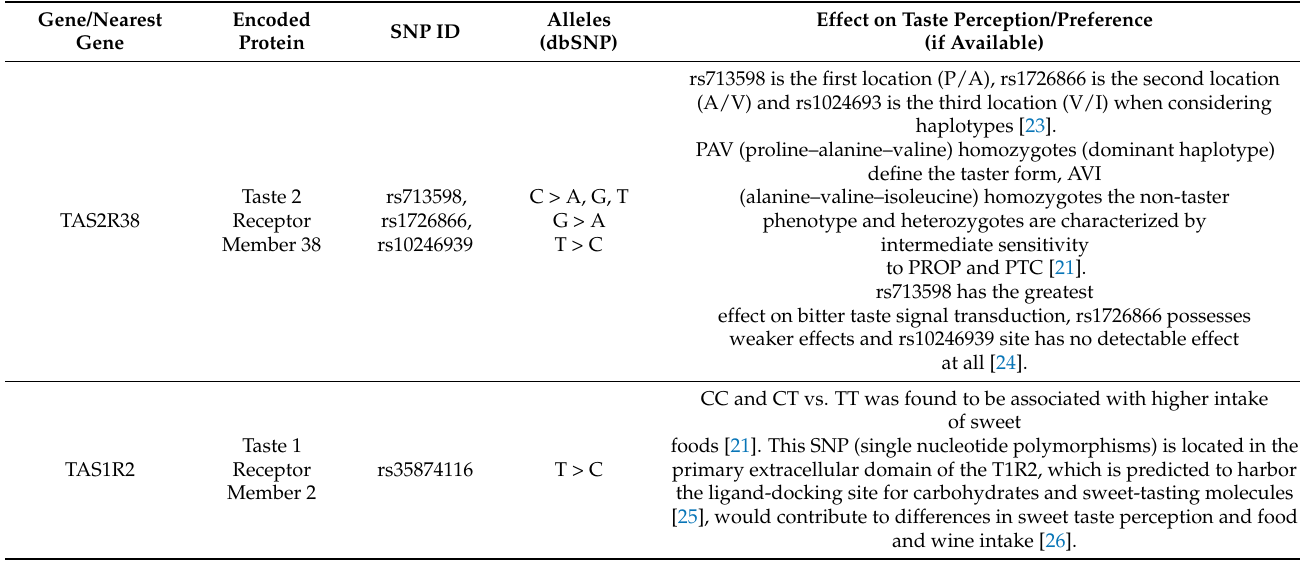
Table 1. Description of single nucleotide polymorphisms included in the review.